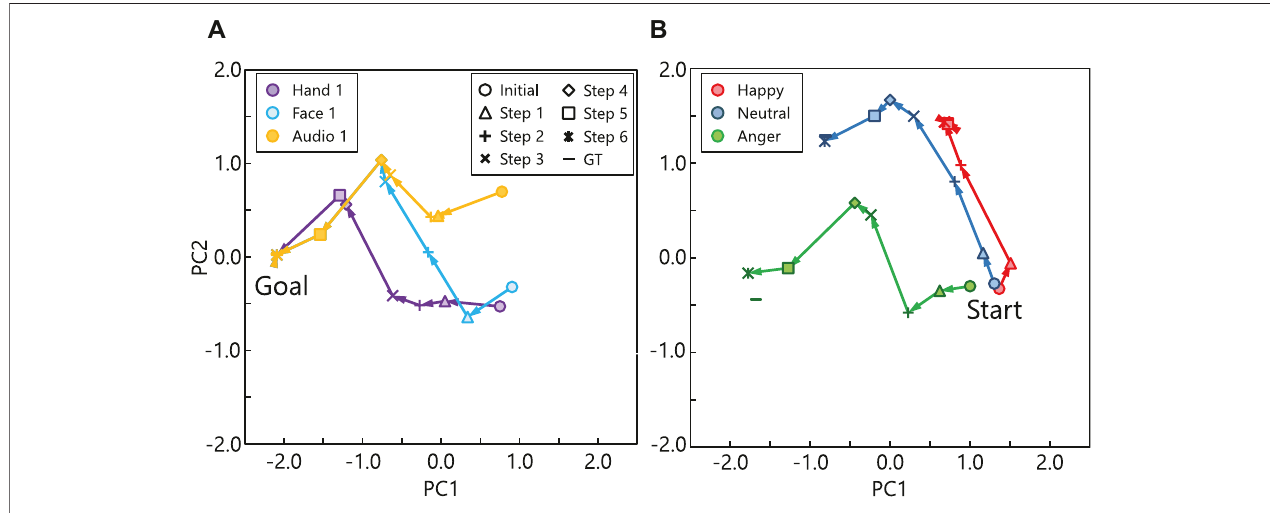
FIGURE 6 | Example transitions of hidden activations in PC space through active inference: (A) transitions of estimation using different initial modalities; (B) transitions of estimation for different emotions.